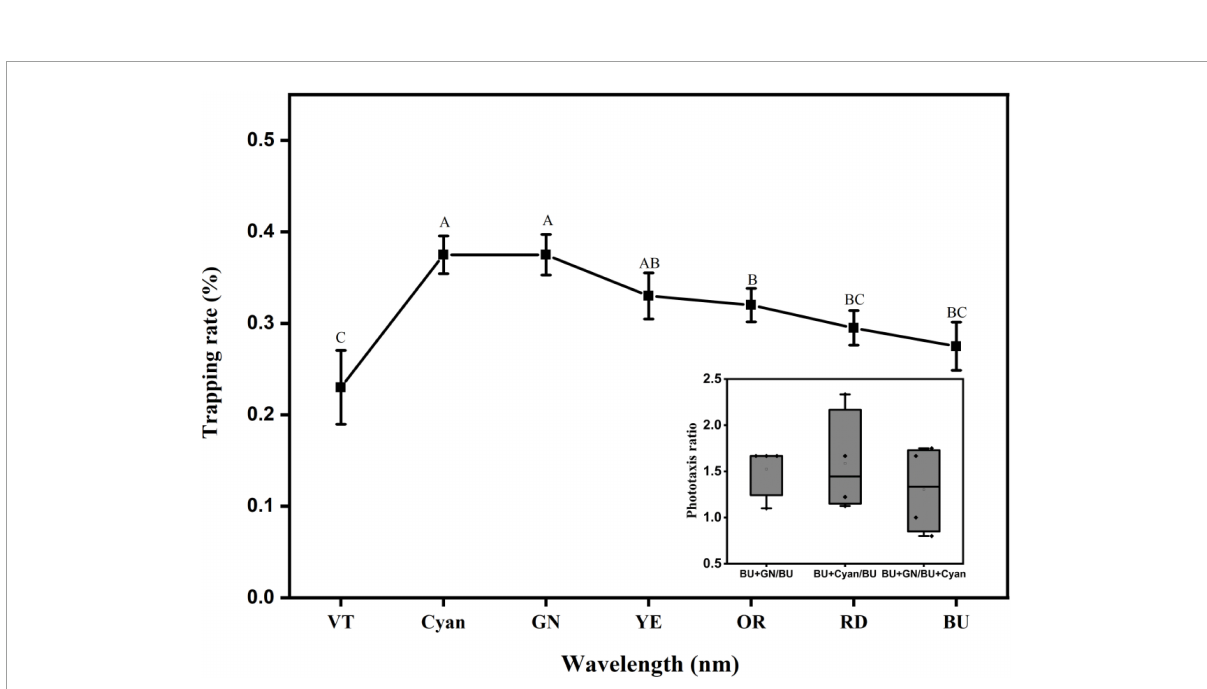
FIGURE13 Curves of the phototaxis response rates of L. striatellus at different polychromatic light levels based on blue light. The horizontal coordinate represents the abbreviation of each monochromatic visible light combined with blue light (VT: violet, Cyan: cyanotype, GN: green, YE: yellow, OR: orange, RD: red, BU: blue). The BU treatment in the figure is the control blue light group. Each value represents the trapping rate T 1 of the adult L. striatellus to the polychromatic light. The error bars represent the standard error. According to the LSD experiment ( p < 0.01), different letters above each group of data indicate significant differences between treatments. The lower right panel shows the phototaxis rate T2 of blue–cyan light, blue–green light, and blue